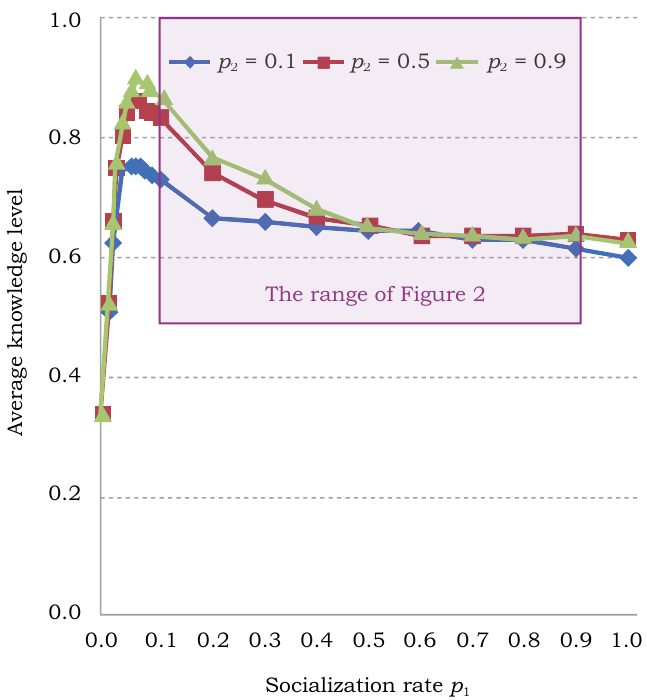
Figure 3. Average knowledge levels of March’s (1991) model with a wide range of 0 to 1 Note: m  30, n  50, 80 periods, 100